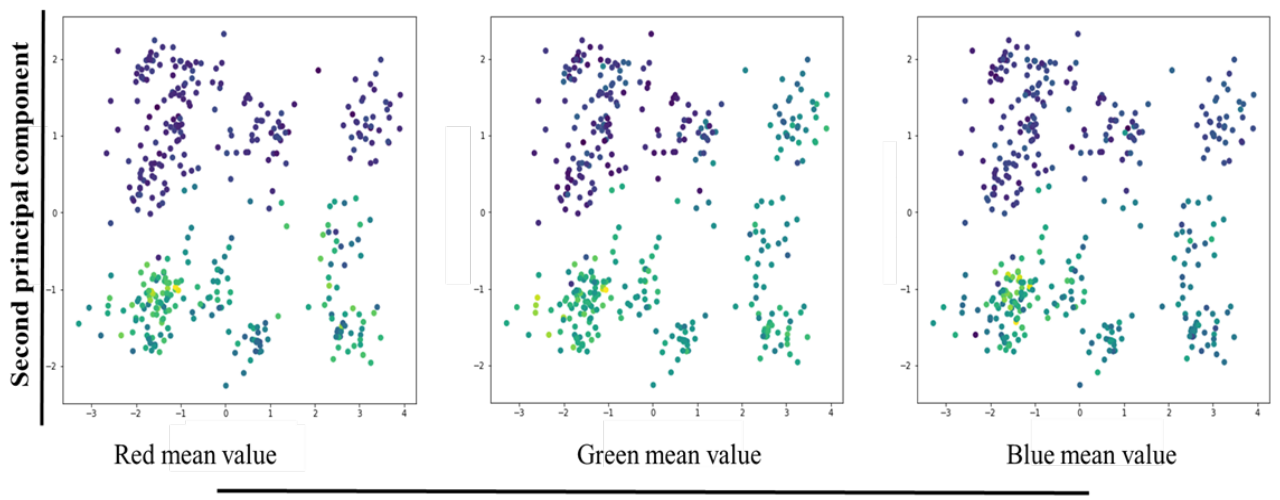
Figure 7. Dimensionality reduction figures of R, G, and B mean values.